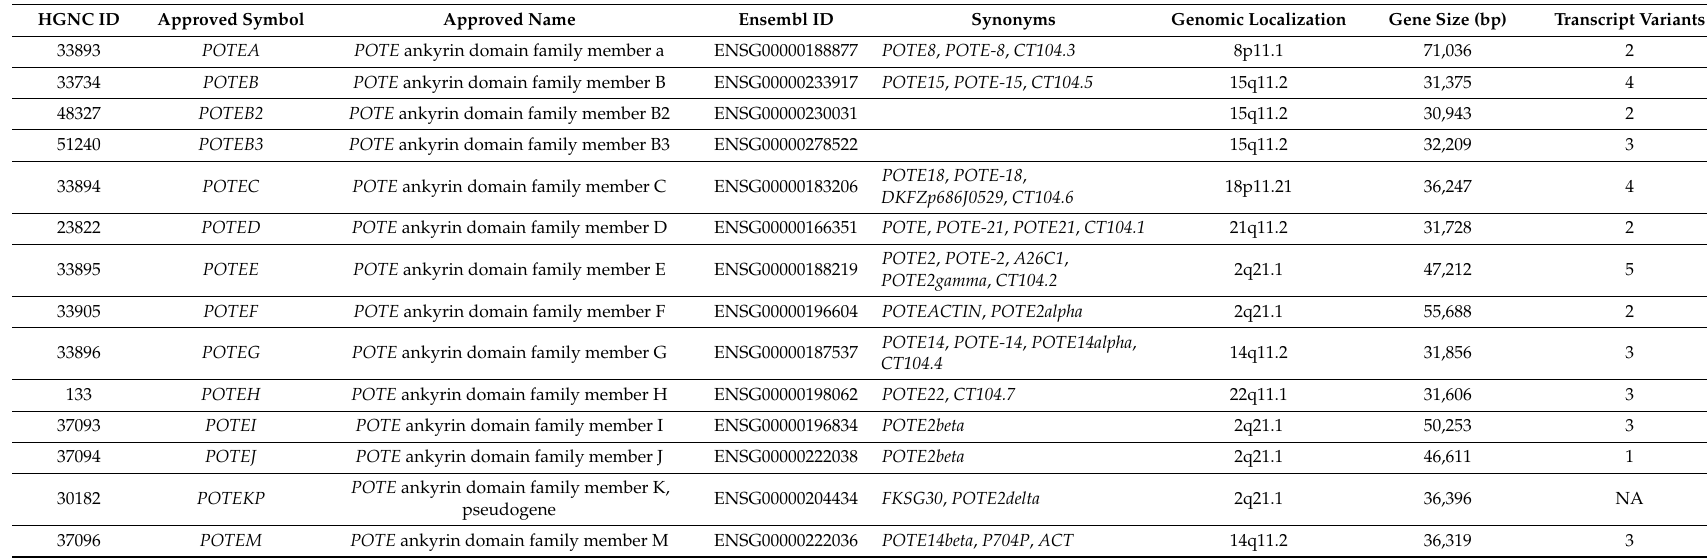
Table 1. Members of the human POTE (prostate, ovary, testis, and placenta expressed) gene